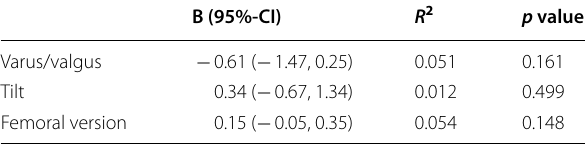
Table 2 95% coefficient interval